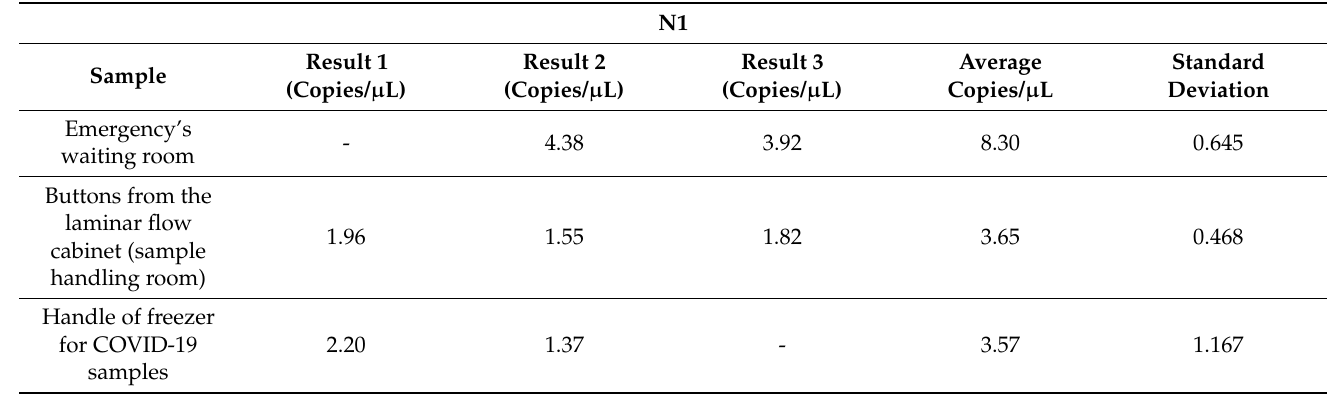
Table 3. Values of gene copies/L and standard deviation for the positive air and surface samples tested in triplicate for the N1